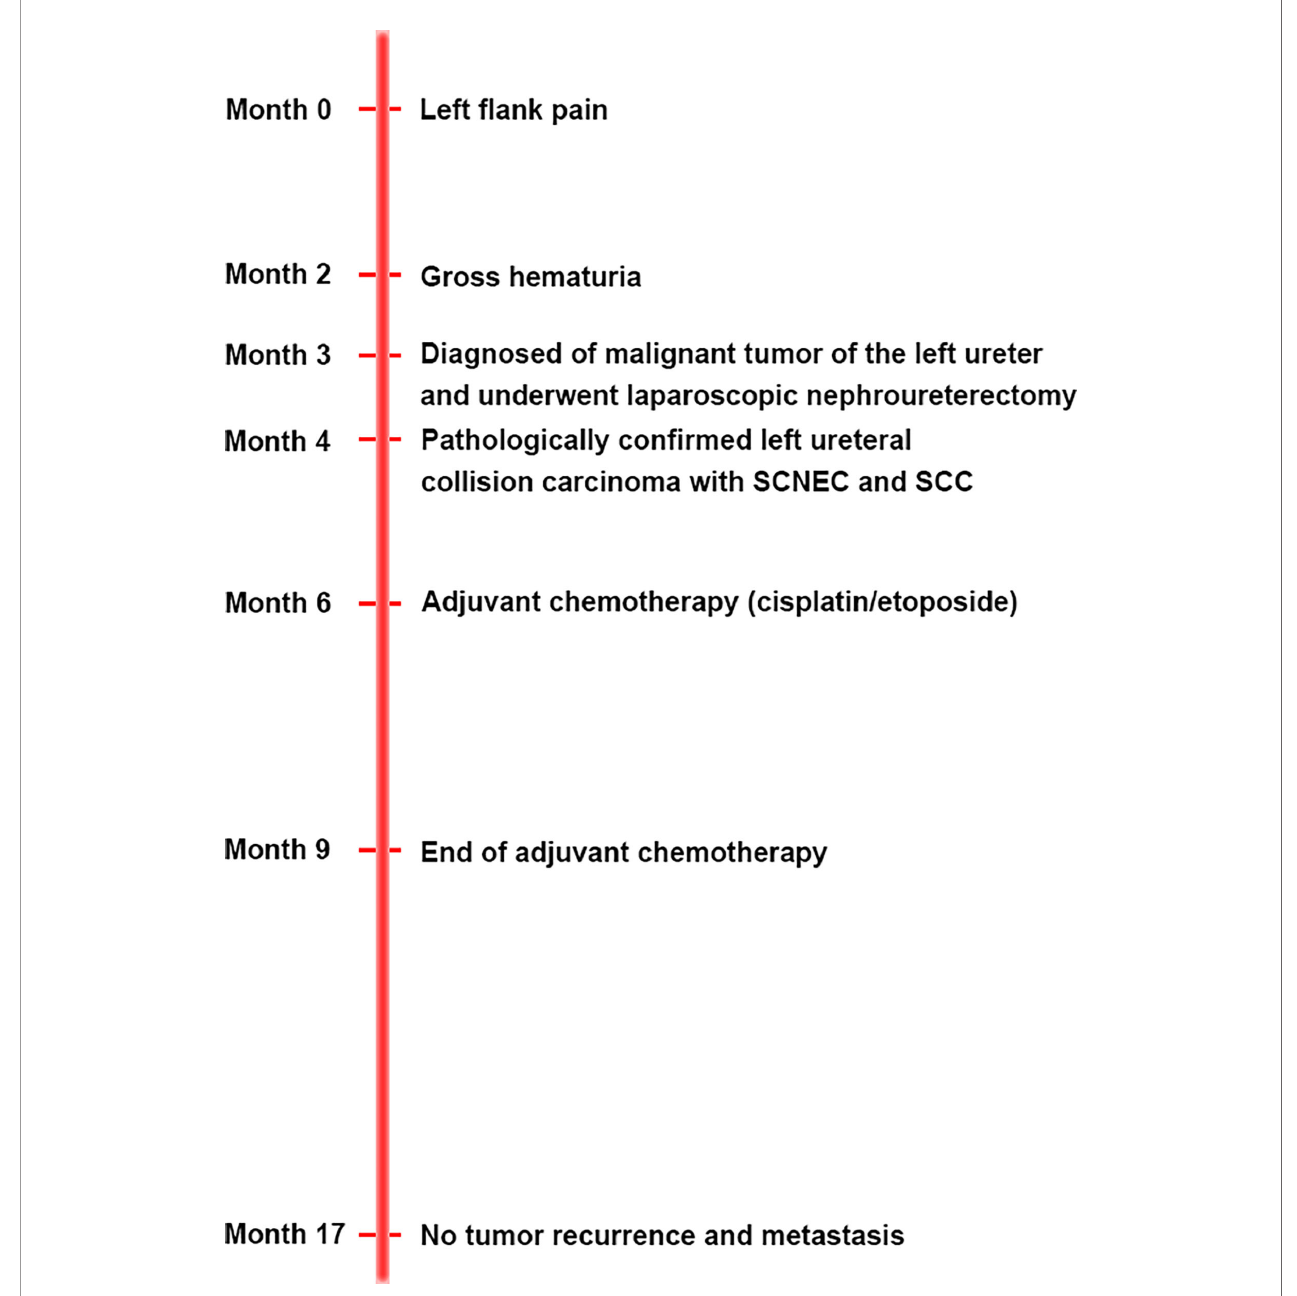
FIGURE 4 | The clinical timeline of the